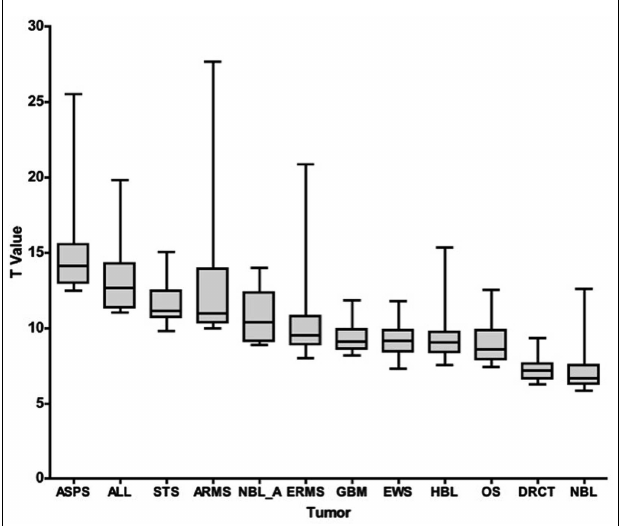
FIGURE 1 | T -Statistic overview of the top 25 tumor-specific transcripts. For each disease category (listed on the x -axis), the range of T -statistic values for the 25 membrane proteins most different from normal tissue, along with their average and quartiles, is represented as a box and whisker